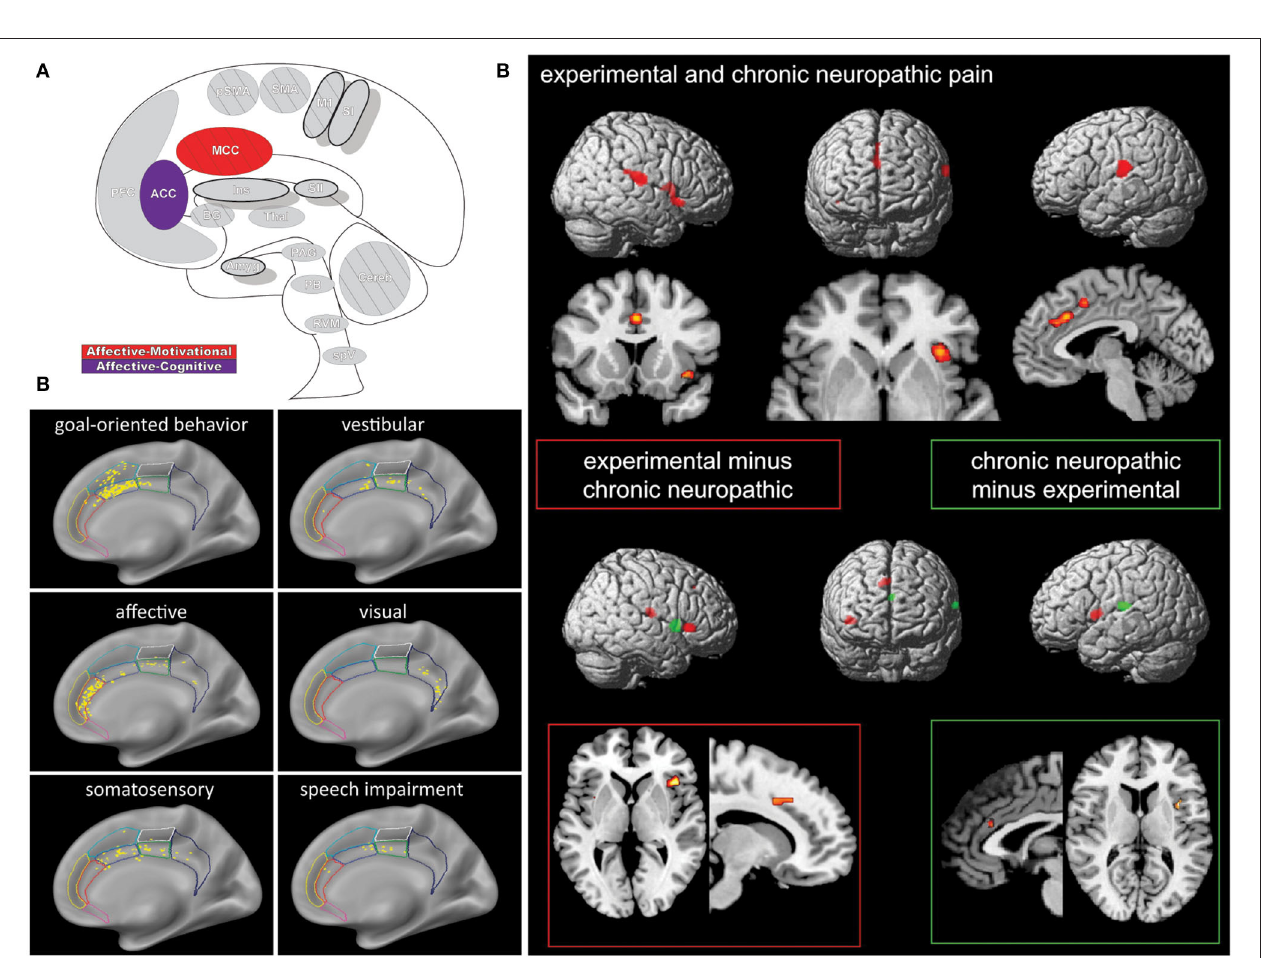
FIGURE 4 | M Liang, A Mouraux, GD Iannetti, Parallel processing of nociceptive and non-nociceptive somatosensory information in the human primary and secondary somatosensory cortices: evidence from dynamic causal modeling of functional magnetic resonance imaging data, p8976–85, Copyright (2011) Liang et al., under the Attribution-Non Commercial-Share Alike 3.0 Unported License (CC BY-NC-SA). DOI: https://doi.org/10.1523/JNEUROSCI.6207-10.2011white dots, activation maxima for each subject within a given region; red dots, activation maxima across the group within a given region.